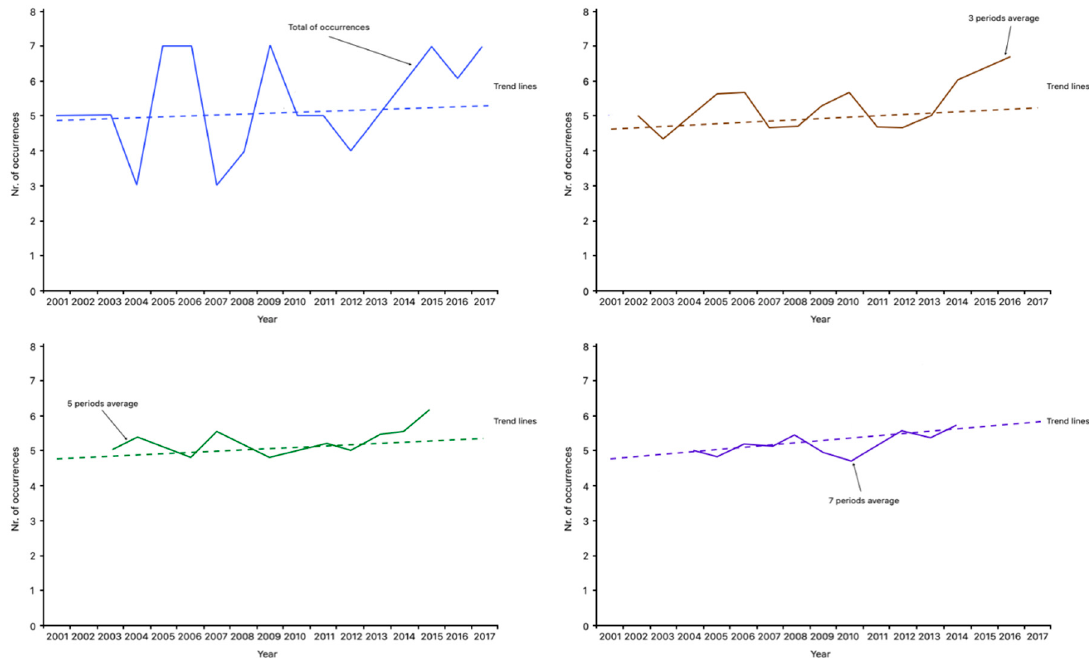
Figure 3. Trend lines. As can be seen in the figures, the lines indicate an increasing tendency for anomalies to occur, allowing it to be inferred that, over the years, an increasing number of anomalies can be expected to occur.